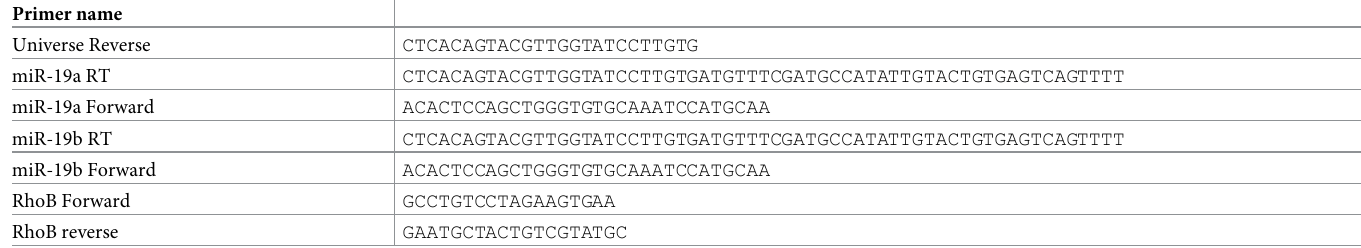
Table 2. Primer sequences used in the present